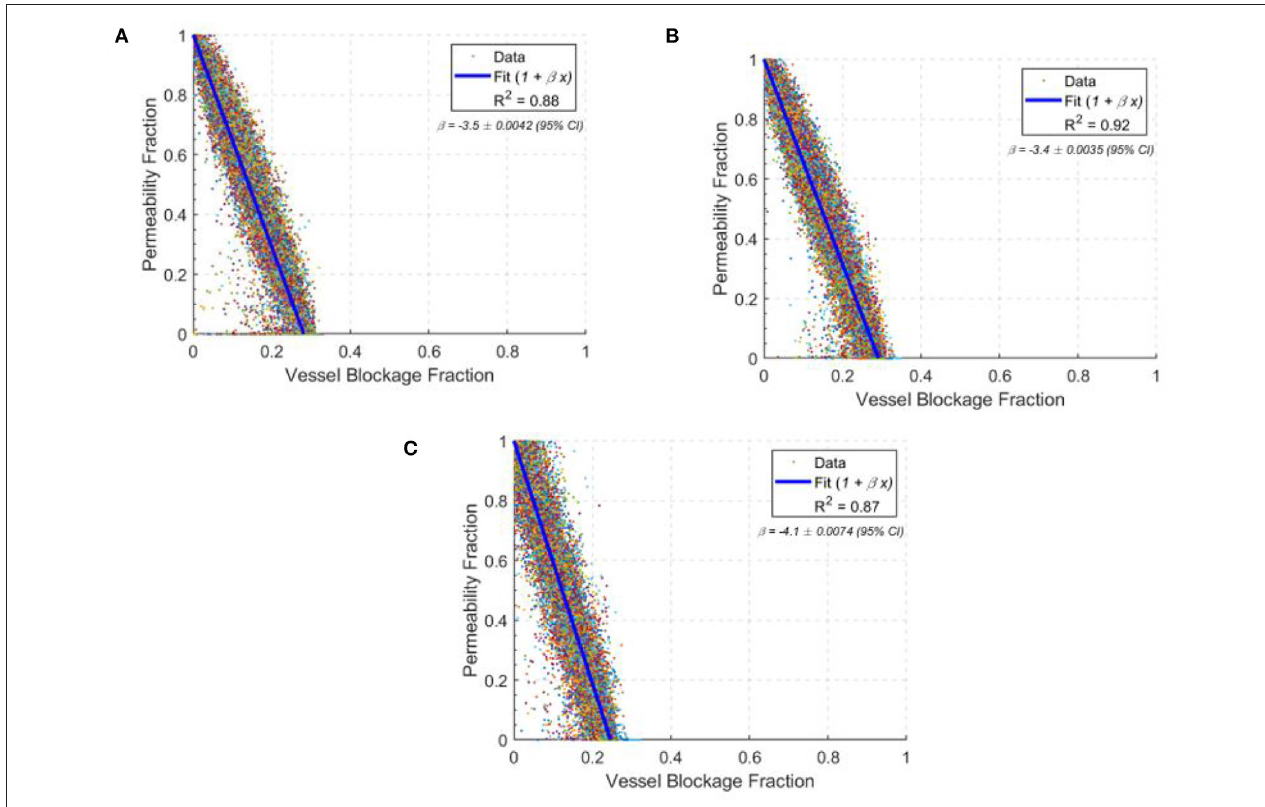
FIGURE 9 | The drops in permeability per vessel blocked in young (A) , middle-age (B) , and old-age (C) for statistically accurate capillary networks. Lines of best fit are in blue with values of the gradient given in the top right corner of each graph. Each data point shows the permeability fraction at any given vessel blockage fraction for a given network, with 166 networks simulated at each age